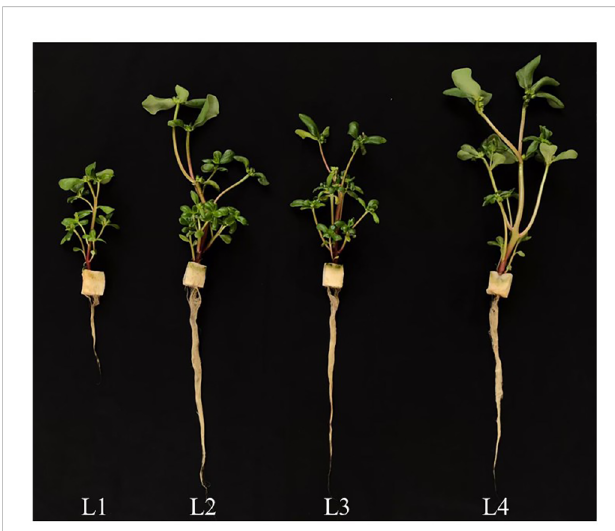
FIGURE 3 Purslane plants grown indoors hydroponically under LED lighting (R/B ratio of 2.2) with different light intensities and durations for 16 days. Refer to Figure 1 for the different conditions of L1, L2, L3 and L4.